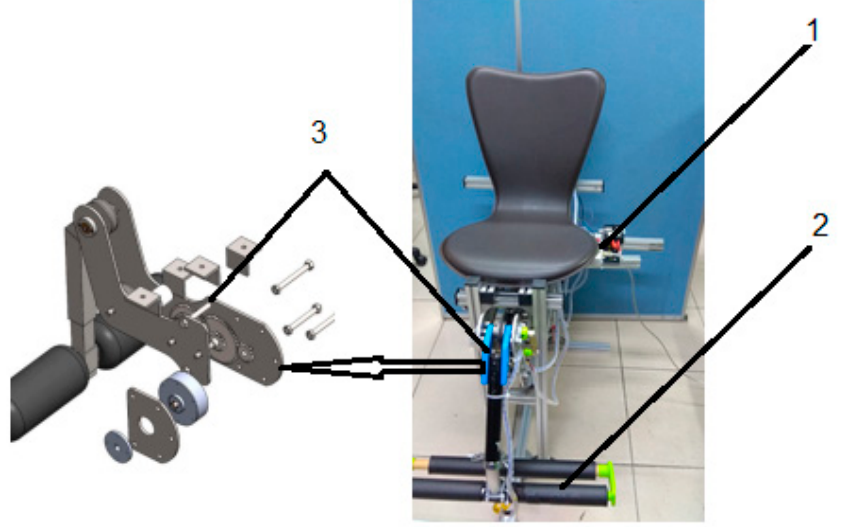
Figure 6. Leg extension machine model (1. The module collects the data from users; 2. force sensor; 3. variable resistance).